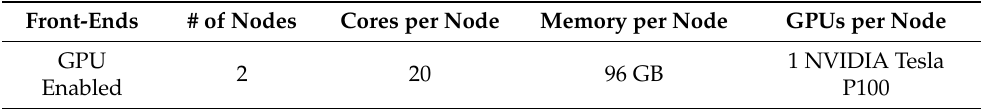
Table 1. Description of the Gilbreth hardware